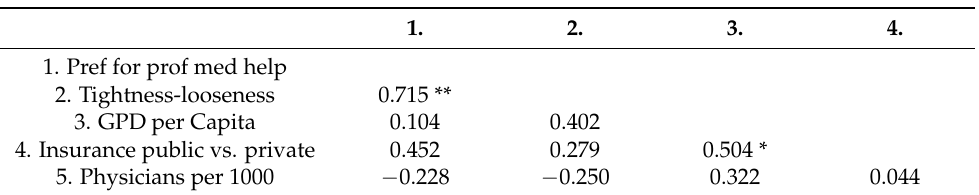
Table A2. Correlation matrix of country level factors and preference for professional medical